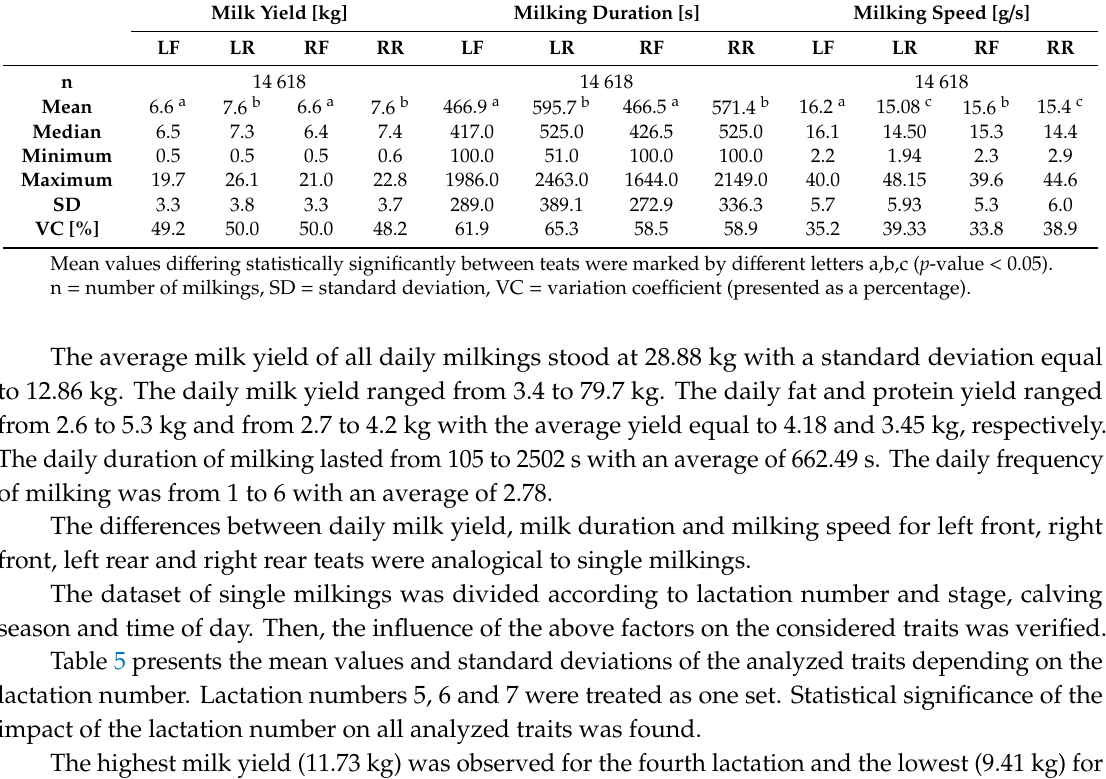
Table 4. Basic descriptive statistics of considered traits for daily milkings from the left front (LF), left rear (LR), right front (RF) and right rear (RR) teats. Trait Milk Yield [kg] Milking Duration [s] Milking Speed [g /